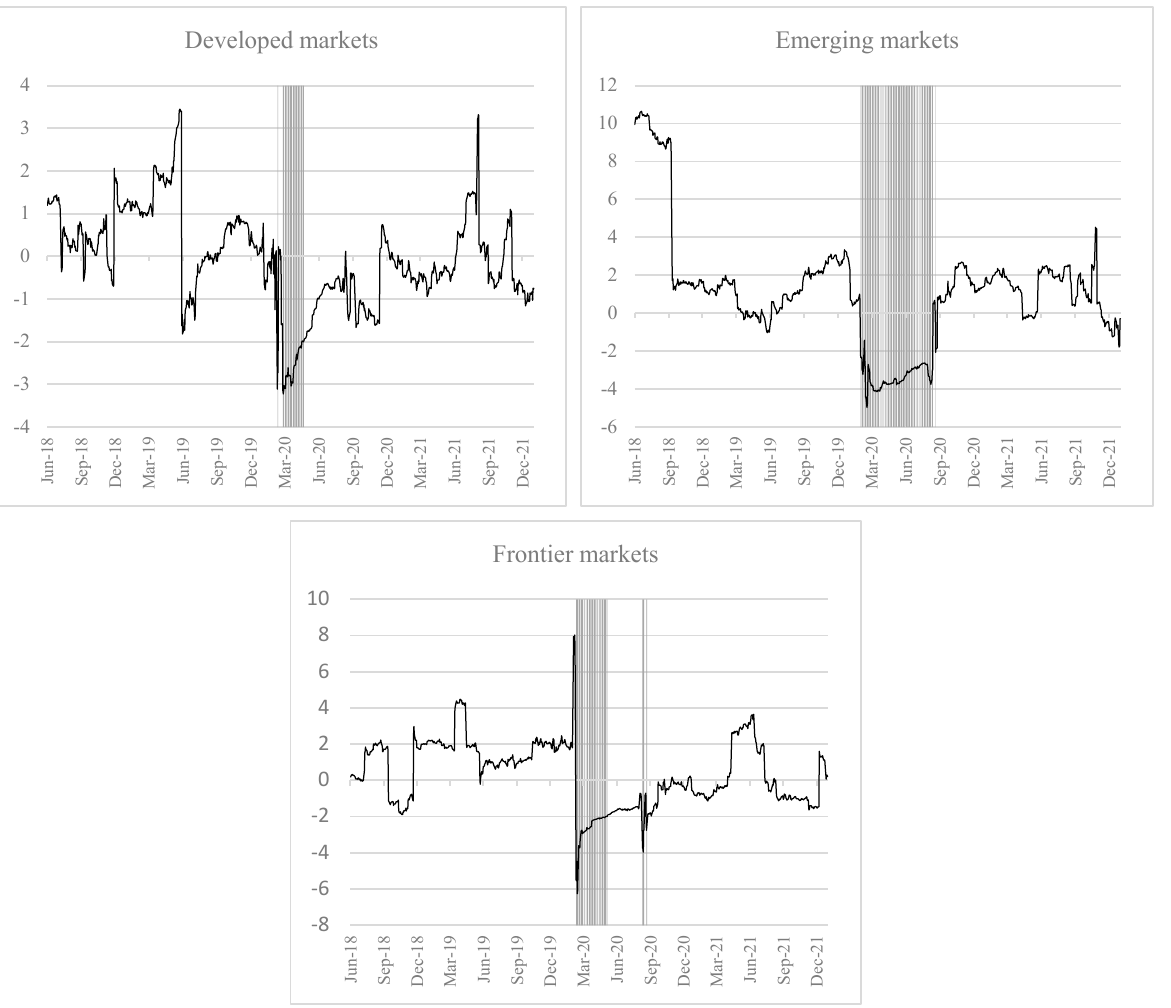
Figure 1. CSAD rolling-window analysis of herd behavior in developed, emerging, and frontier European equity markets.